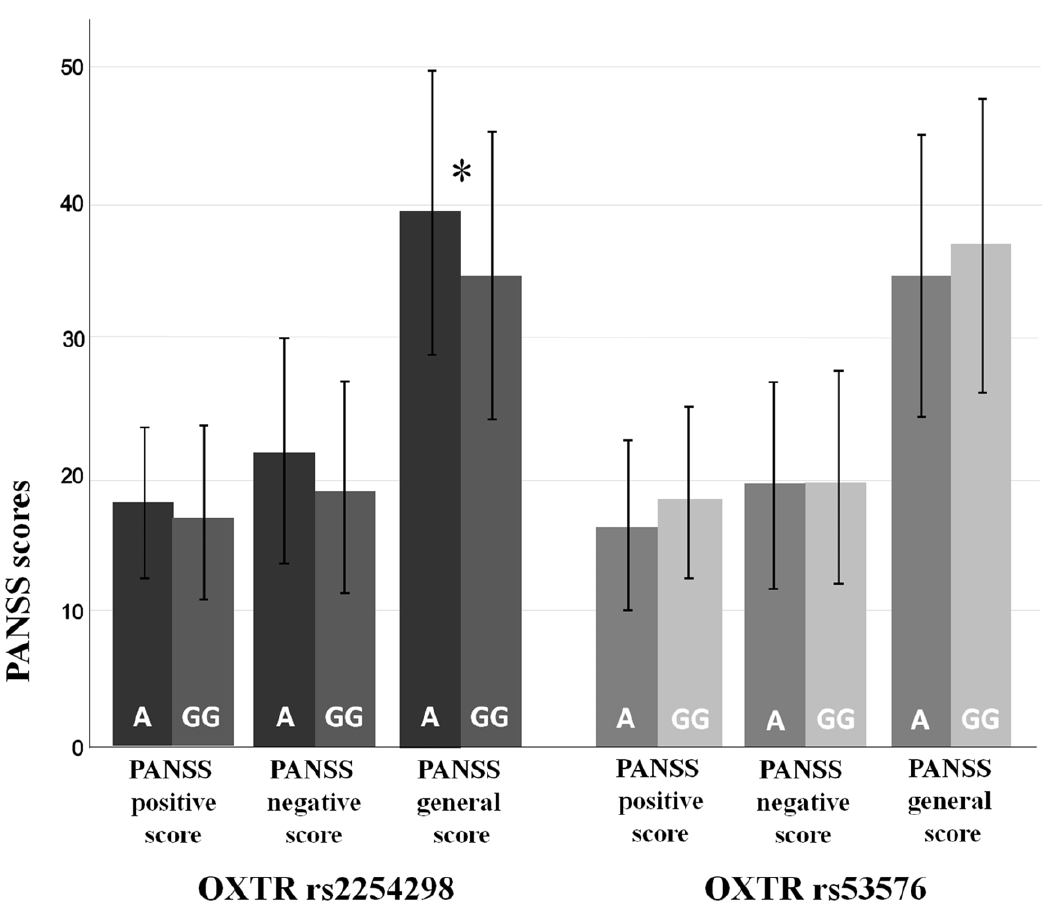
Figure 2. OXTR rs2254298 and rs53576 polymorphisms and PANSS positive, negative and general psychopathology scores in schizophrenic patients. Schizophrenic patients carrying AA- or AG-genotypes of OXTR rs2254298 show significantly higher PANSS general psychopathology scores than GG-carriers (n=145; mean, SD; t-test for independent samples, *: p , 0.05).